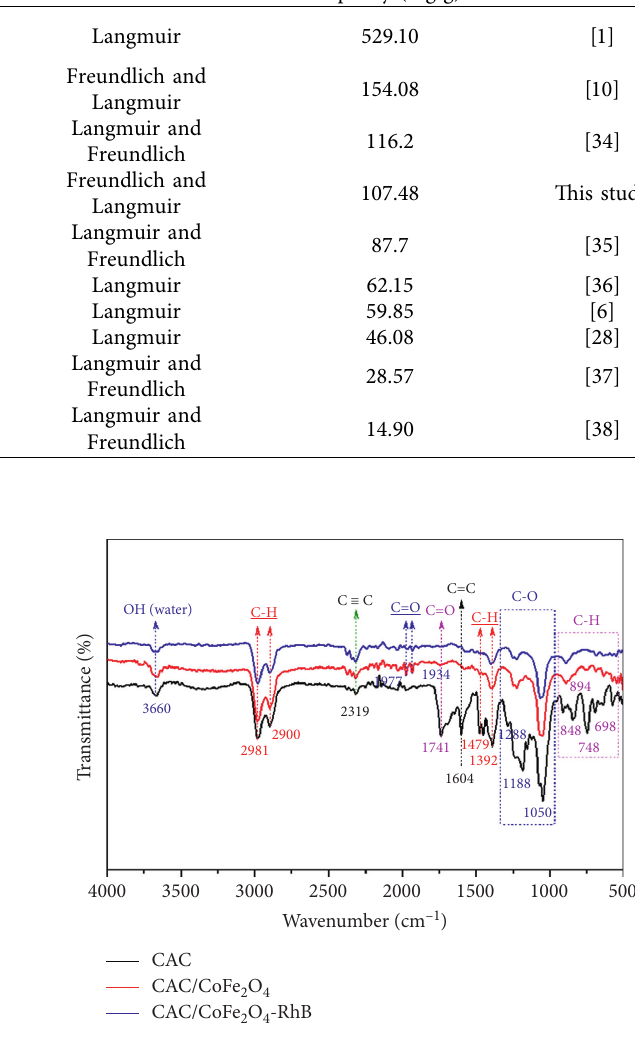
Table 2: Comparison of RhB adsorption capacity on CAC/CoFe Adsorbent